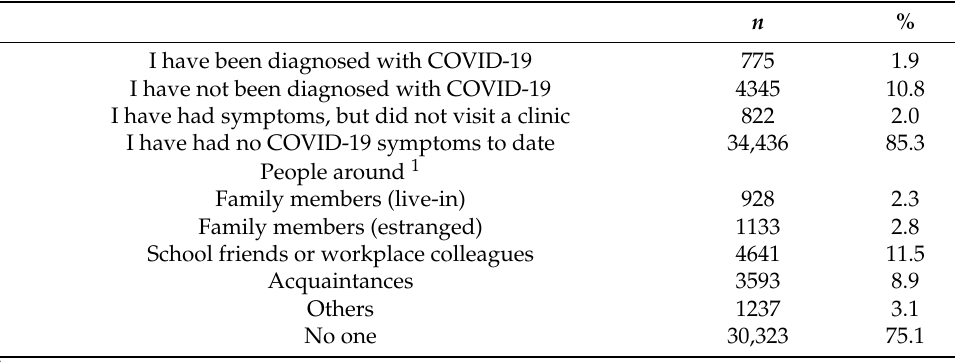
Table 2. Experience of SARS-CoV-2 infection.